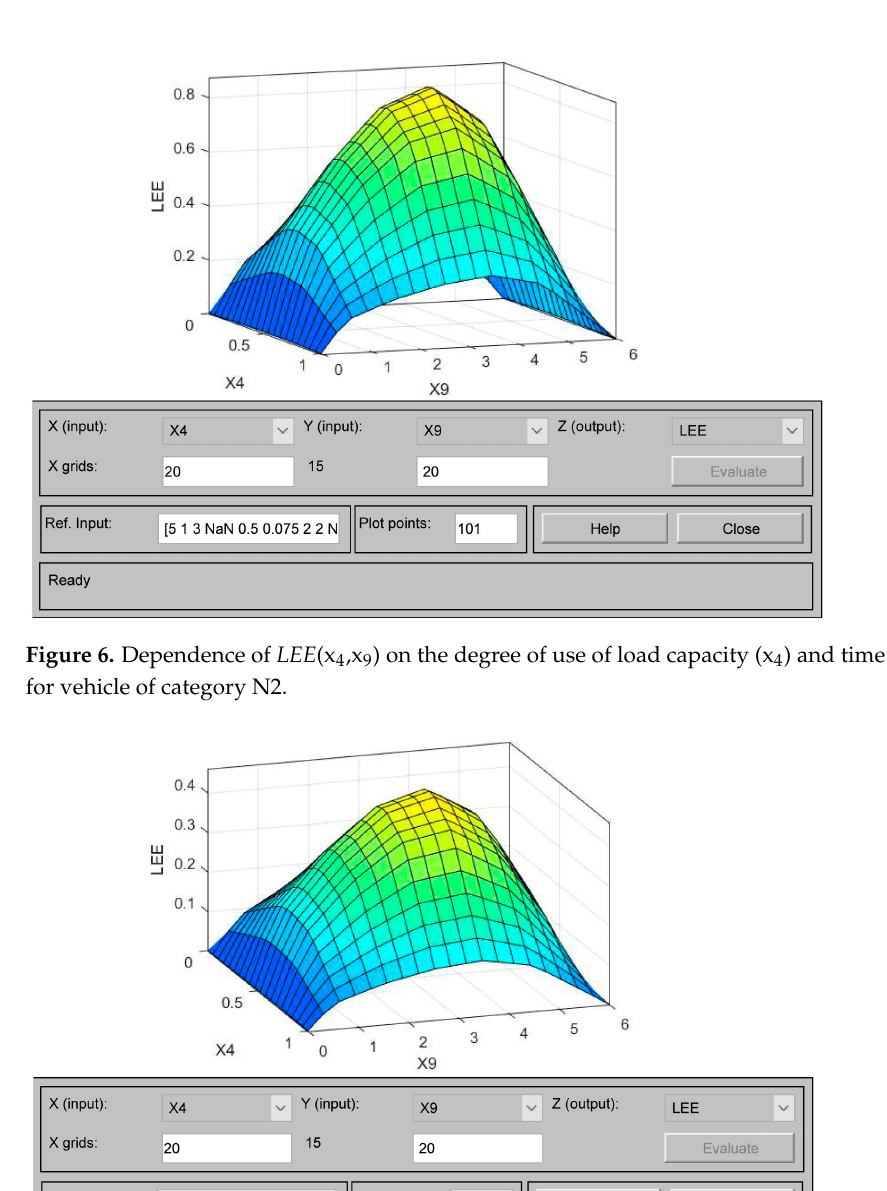
( b ) Figure 5. Optimal values of the LEE ( x 4 , x 5 ) : ( a ) bus, ( b ) truck. When the vehicle category changes from a smaller value to a larger value (see Table 2), the gradient of the LEE ( x 4 , x 5 ) decreases, and the area of LEE values close to the maximum narrows (Figure 4). Therefore, changing these system parameters has a greater effect on the energy efficiency of a bus than of a truck.